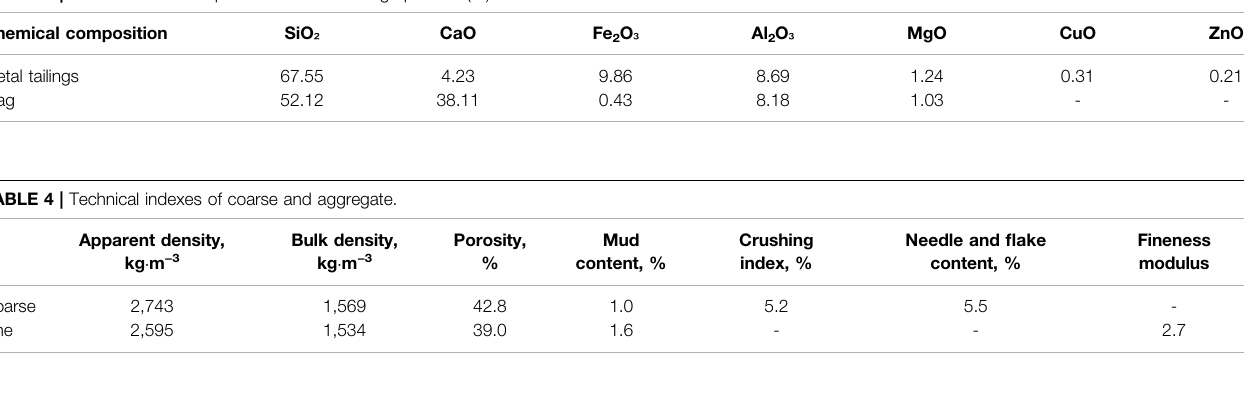
TABLE 3 | Main chemical components of metal tailings powder (%).